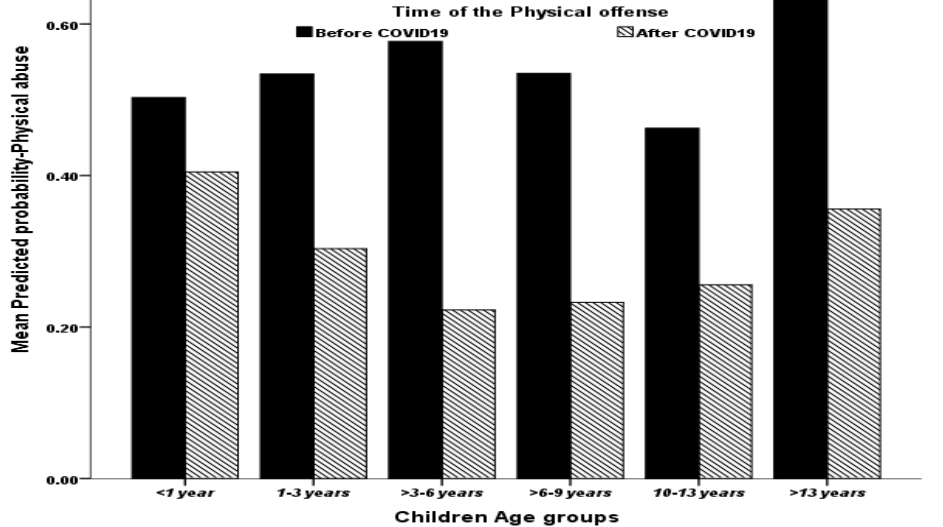
Figure 1. The association between children’s age group and their mead model-predicted probability of being physically maltreated.